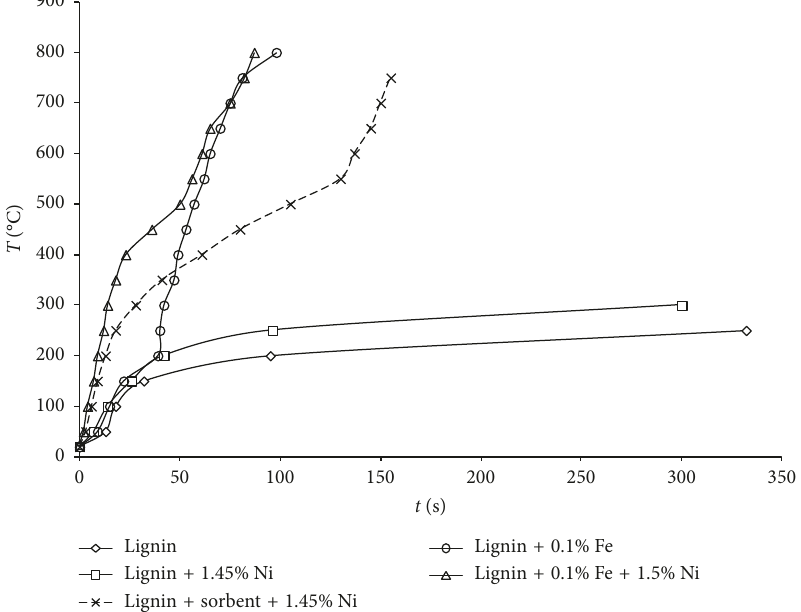
Figure 3: Dynamics of heating of kraft lignin samples. Table 1: Material balance of kraft lignin